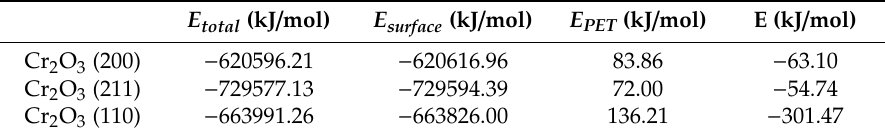
Figure 12. The binding energy of the Cr 2 O 3 surface with PET. Table 3. The element content of the TFS